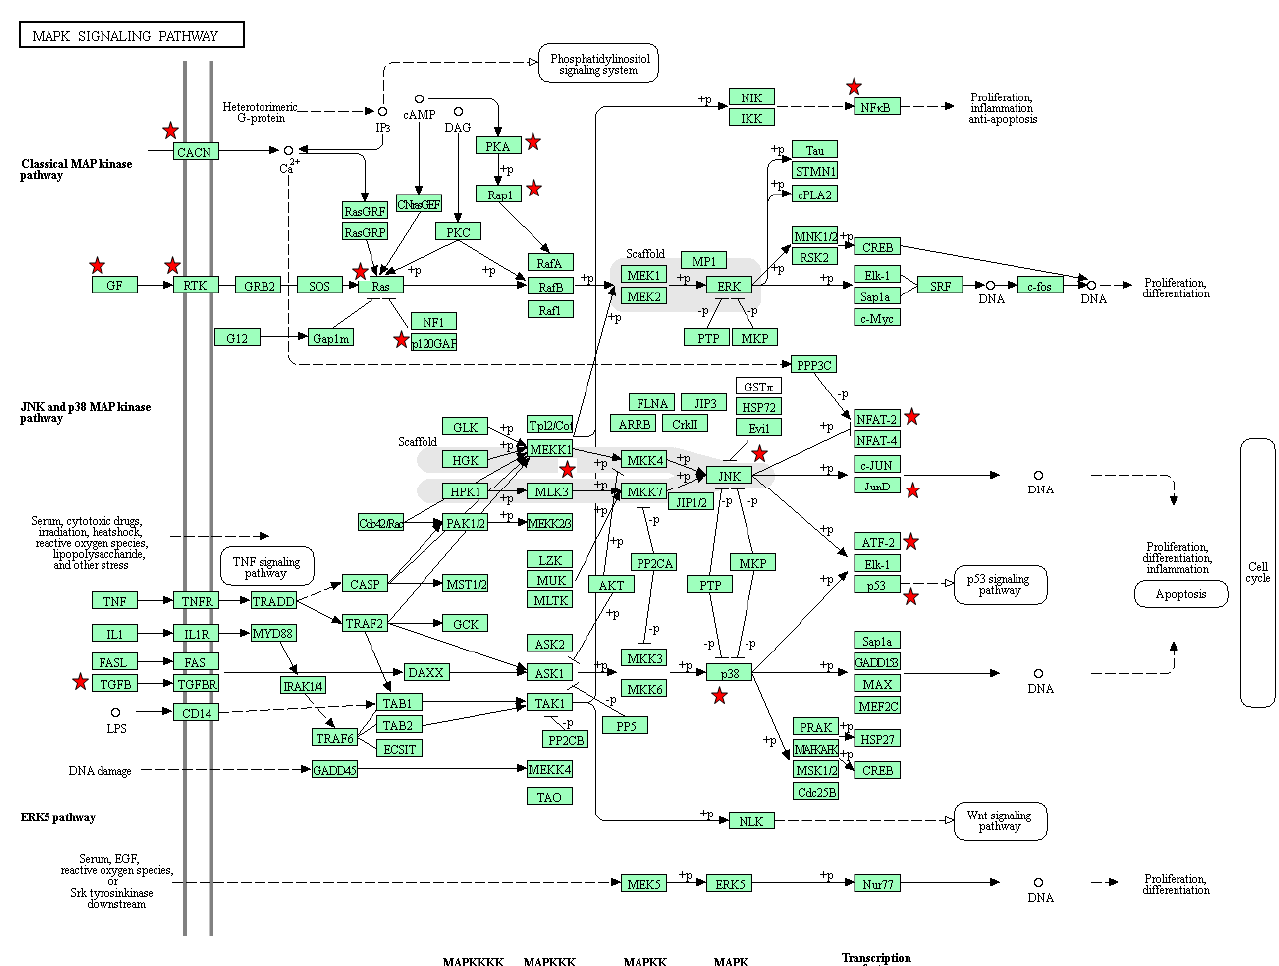
Figure 7. MAPK signaling pathway from KEGG database.